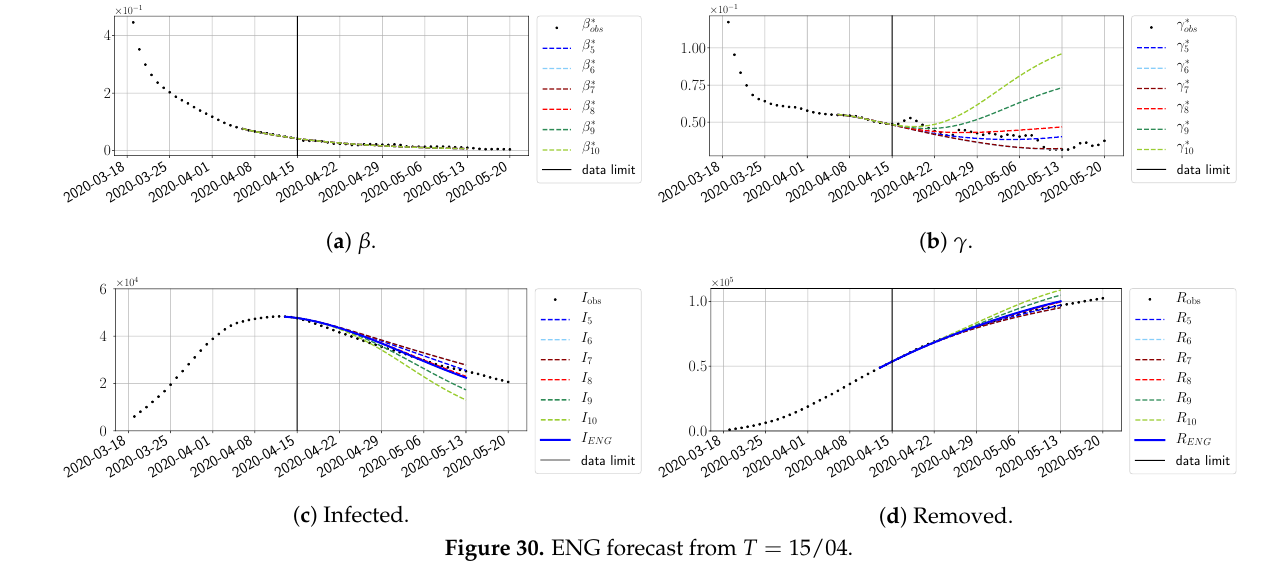
Figure 30. ENG forecast from T = 15/04.